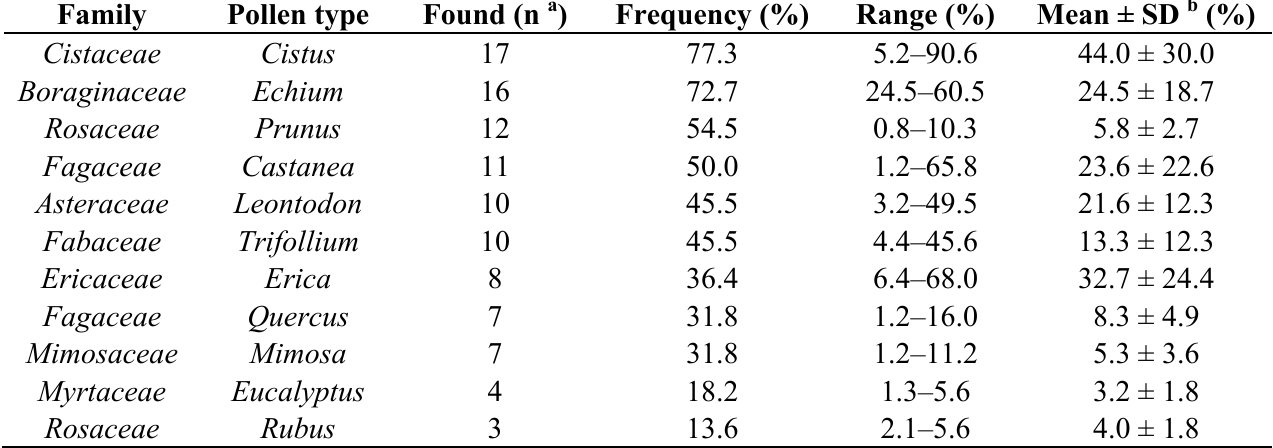
Table 1. Frequency classes (presence, range and mean ± SD) of the pollen types in the organic apian